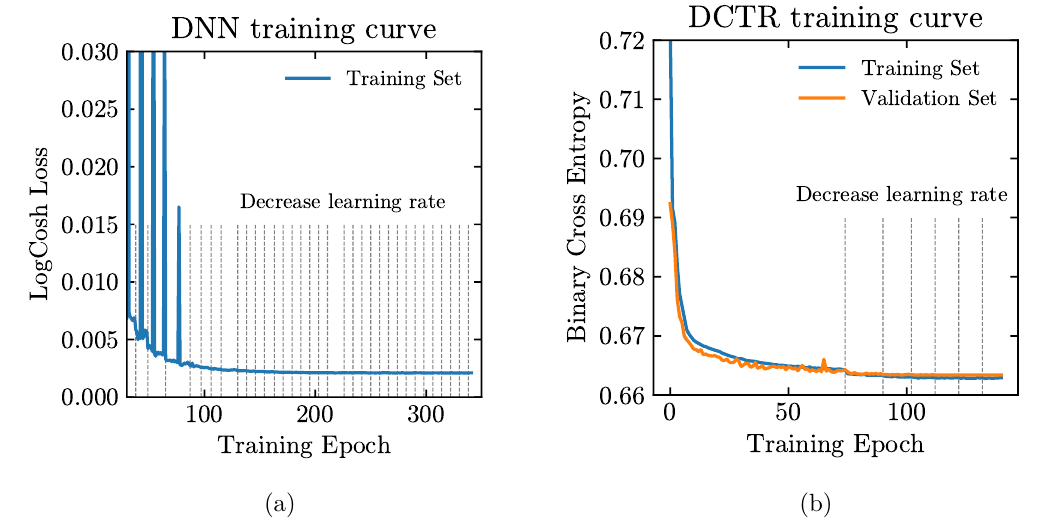
Figure 18. (a): training loss curve for linear network. (b): training loss curve for DCTR classifier.